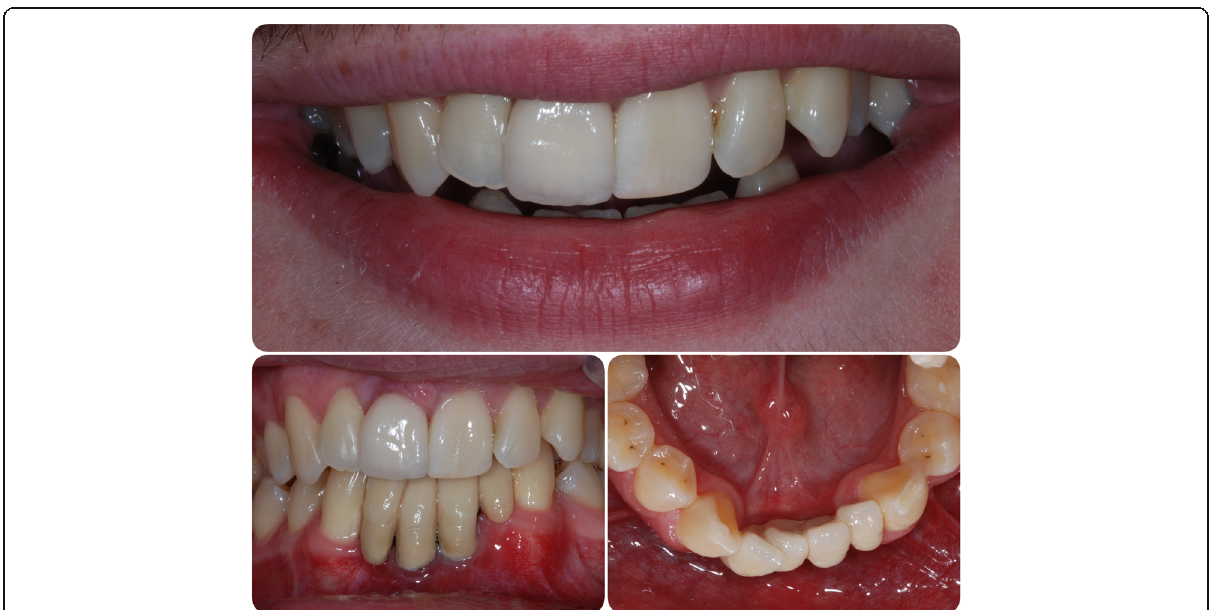
Fig. 6 Mandible restored. Fixtures in 31 and 41 positions restored with four-unit bridge